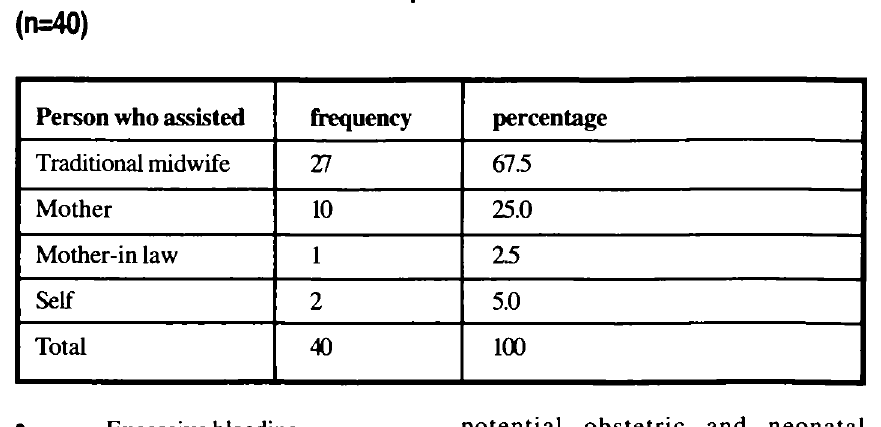
Table 7 Persons who assisted respondents who delivered at home